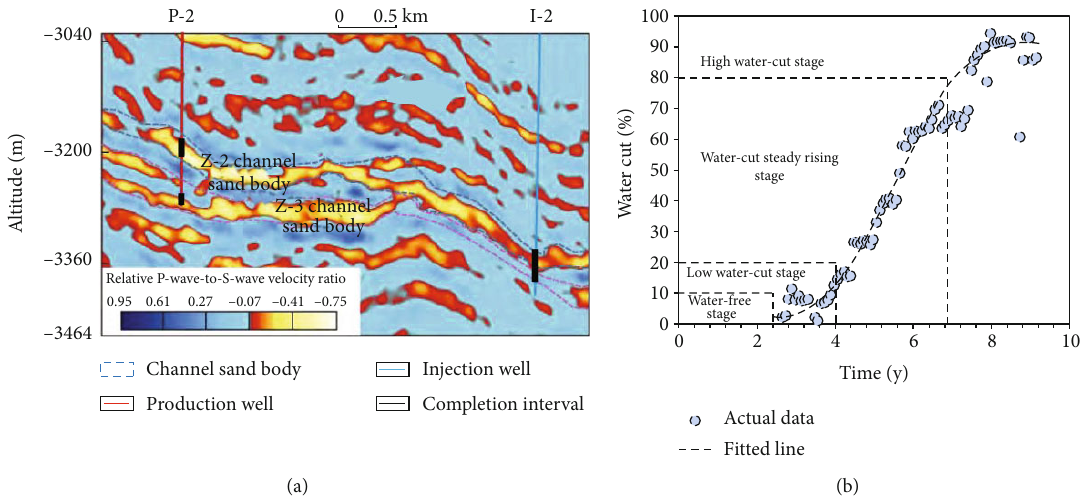
Figure 2: A typical well of Mode II: (a) seismic section images; (b) water-cut changing law.